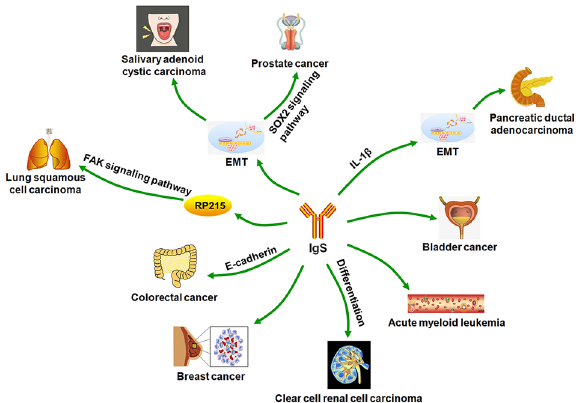
Fig. 5 Schematic illustration of the mechanisms that tumor- derived Igs enhanced tumor cell migration, invasion, and metastasis. Tumor-derived Igs augmented multiple tumor cell migration, invasion, and metastasis through positively or negatively regulating the following cell signaling pathways or biological processes or important molecules, including SOX2 signaling pathway, FAK signaling pathway, EMT, differentiation, IL-1 β , and E-cadherin.